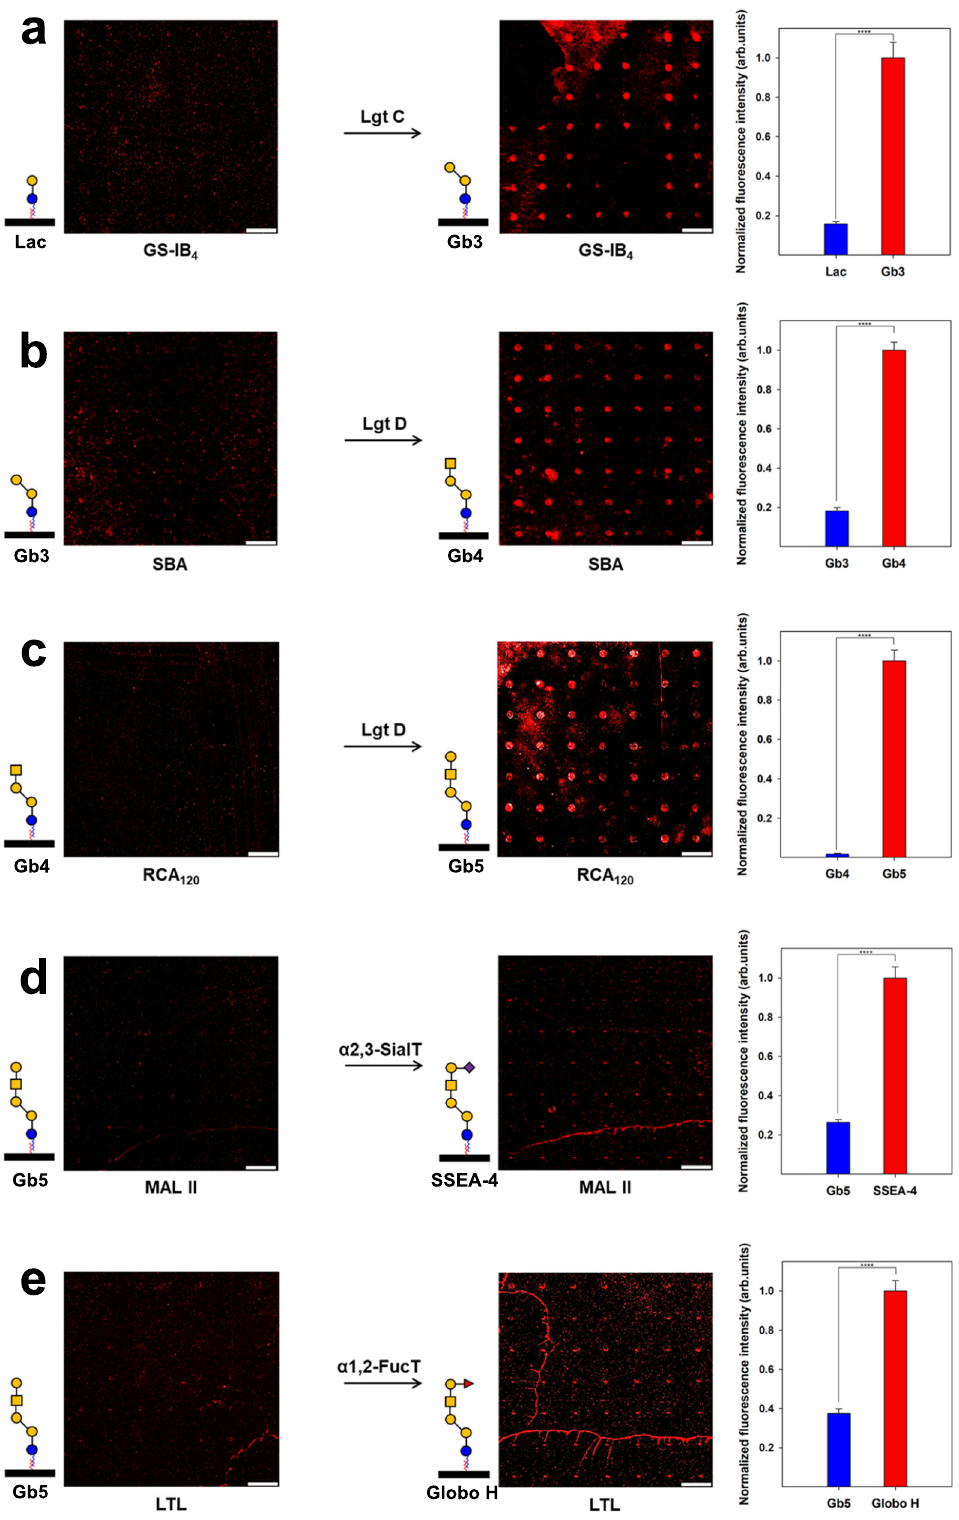
the i-motif DNA and quantitatively analyzed using liquid chro- matography to determine the conversion ef fi ciency for the bio- synthesized glycans (Fig. 3a). The LgtC enzyme was treated on a lactose disaccharide-immobilized surface for 12, 24, and 48 h at 37 °C. Initially, Gb3 trisaccharides were enzymatically synthesized slowly at a conversion ef fi ciency of ~14%, but after 48 h, all lac- tose disaccharides were converted to Gb3 trisaccharides on the